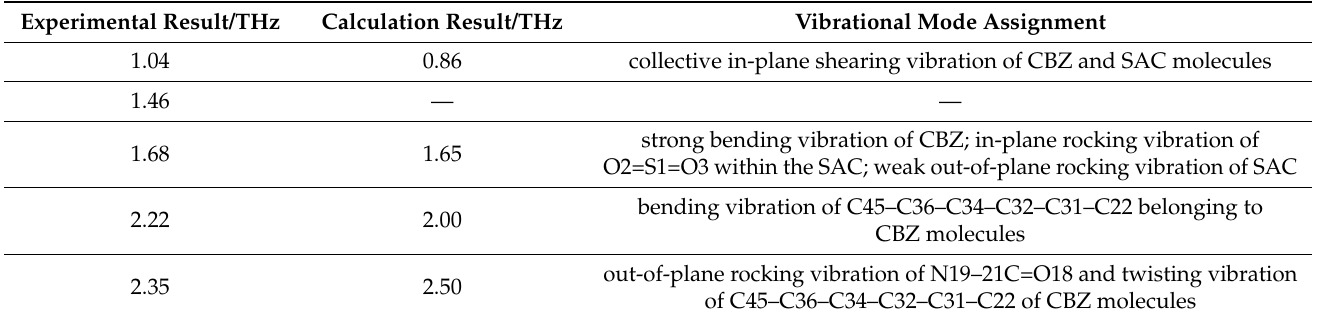
Table 2. Vibrational mode assignment of the CBZ-SAC co-crystal shown in THz